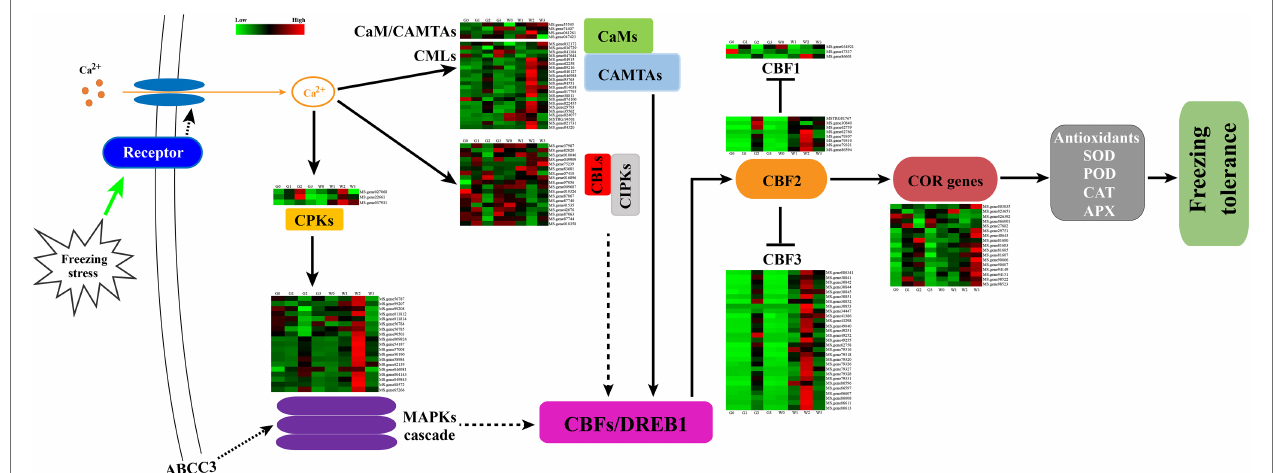
FIGURE 9 | Hypothetical schematic diagram for the mechanism of tolerance to abrupt freezing stress in alfalfa. Freezing stress induced calcium signal transduction through CaMs, CMLs, CBLs, and CPKs. CPKs directly responded to the signal transduction and active MAPKs were involved in the downstream CBFs/DREB1 expression. CaMs and CBLs interacted with CAMTAs and CIPKs, respectively, and regulated the genes of CBFs/DREB1. CBF1, CBF2, and CBF3 trigged an expression of COR genes, which resulted in an increase in the activities of SOD, POD, CAT, and APX. We hypothesize that the hub gene ABCC3 was involved in the MAPK signal pathway and regulated the related genes of CBFs expression. This may have triggered the COR genes and led to an increase in antioxidant enzymes that counteracted abrupt freezing stress in the alfalfa leaves. The dashed arrows indicate that the mechanism is unclear, and CBF2 reduced the expression of CBF1 and